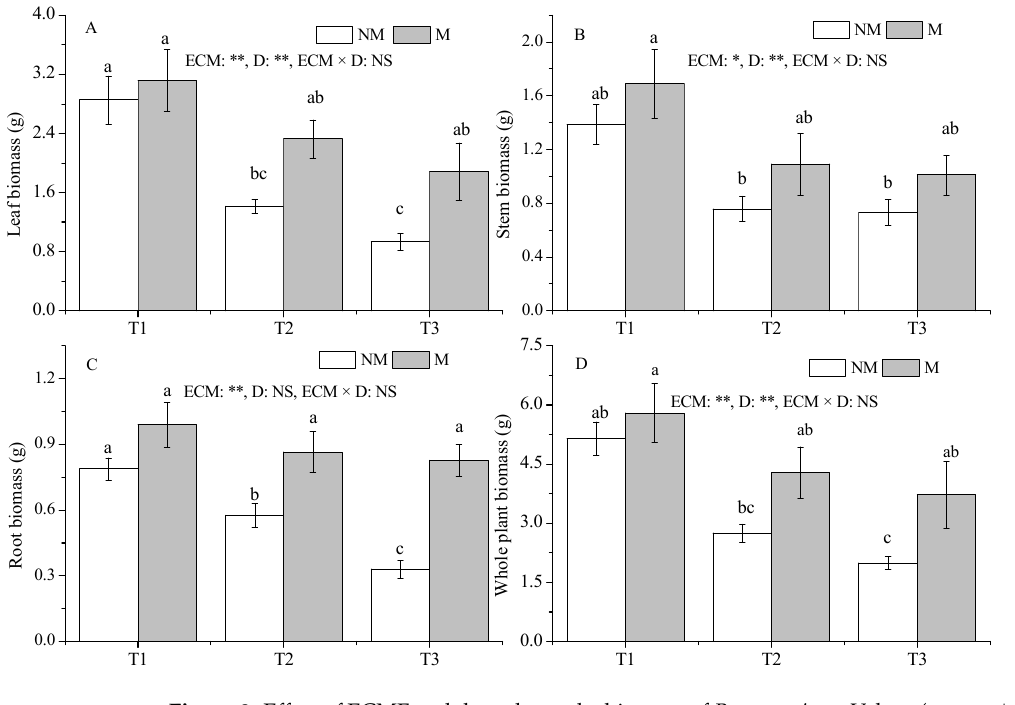
Figure 3. Effect of ECMF and drought on the biomass of P. massoniana. Values (means ± SEs) followed by different letters among treatments indicate significant differences at the 5% level, and the same letter indicates no significant difference. NS, not significant, * p < 0.05; ** p < 0.01. T1, well-watered, T2, moderate drought, and T3, severe drought. NM, no Sl inoculation, M, Sl inoculation. D, drought treatment. The letters denote ( A ) leaf biomass; ( B ) stem biomass; ( C ) root biomass; ( D ) whole plant biomass.